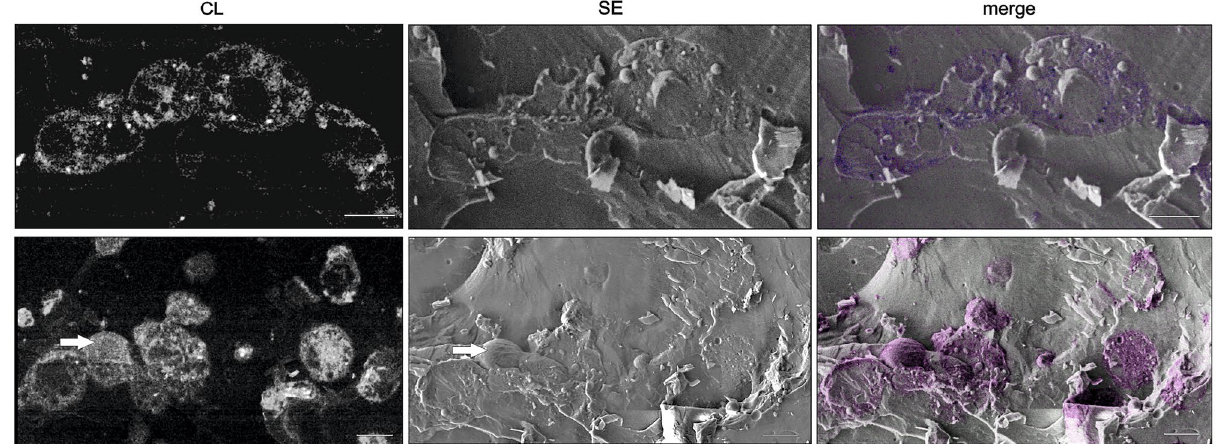
Figure 2. SEM of freeze fractured Vero cells stained in vivo with REZOLVE-ER. Corresponding images were taken using Crytur cathodoluminescence detector (CL) and the Everhart–Thornley detector (SE) at − 140 °C and 5 keV. The CL image was colourised and merged with the SE image to illustrate the exact structural overlay. The CL signal helped find positions of stained cells in the fractured area and identify labeled cellular compartments. The arrow marks the intact cell. SEM JEOL 7401F. Bars: 10